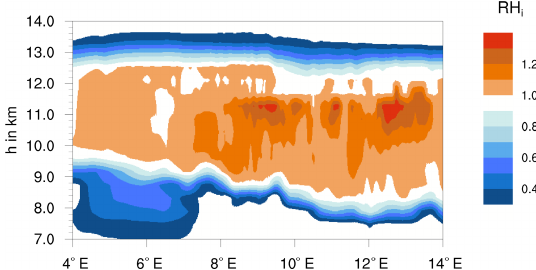
Figure 5. Vertical cross section of relative humidity RH i at 12:00UTC along the black line in Fig. 4.